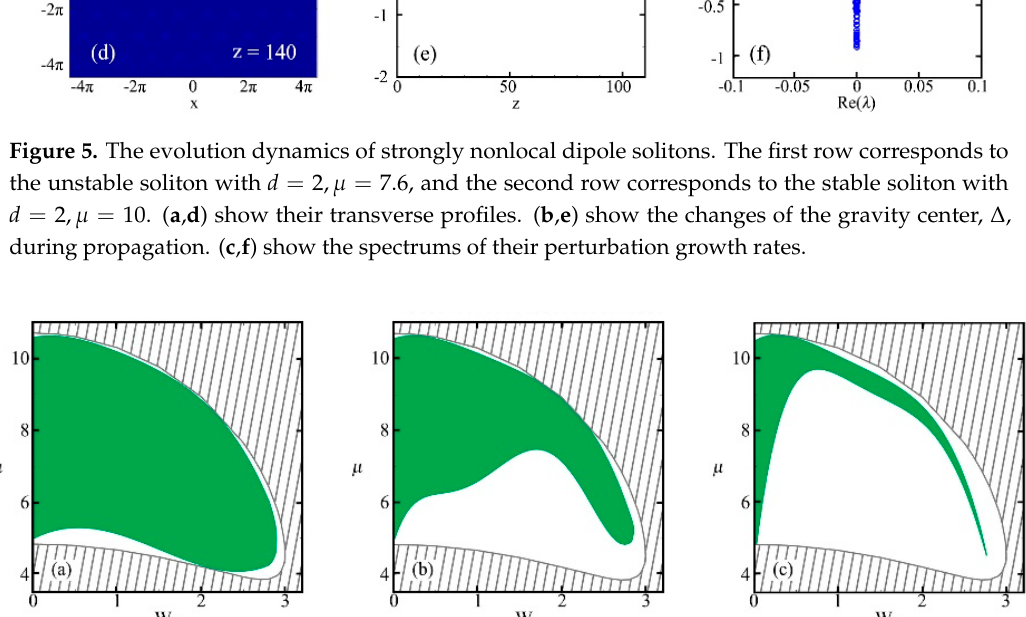
Figure 6. The existence range of dipole solitons in nonlocal nonlinear triangular lattices with different degrees of gain / loss. ( a – c ) correspond to weak ( d = 0.05), intermediate ( d = 0.5), and strong ( d = 2) nonlocalities, respectively. The shaded areas represent the optical energy band for linear optical modes. The green areas represent the parameter ranges in which dipole solitons can exist.